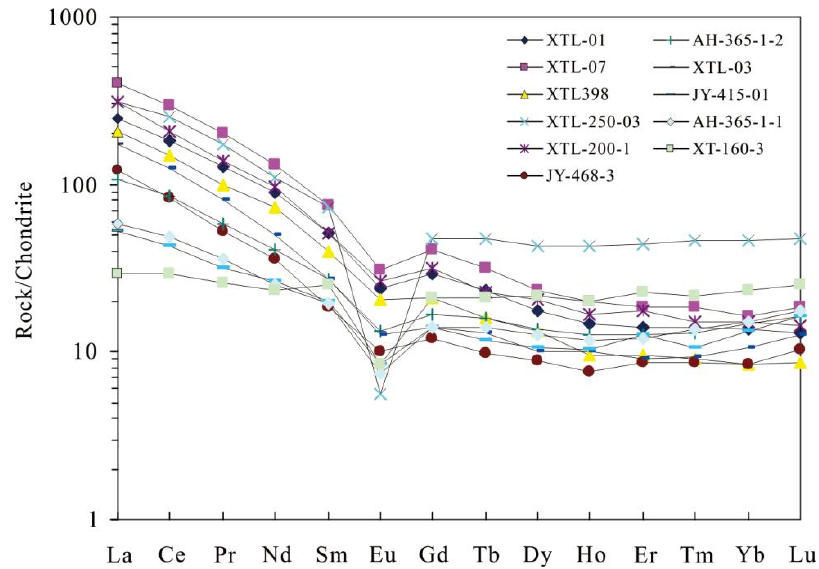
Figure 9. Chondrite-normalized REE patterns for granites in Xintianling ore field, Hunan, China.